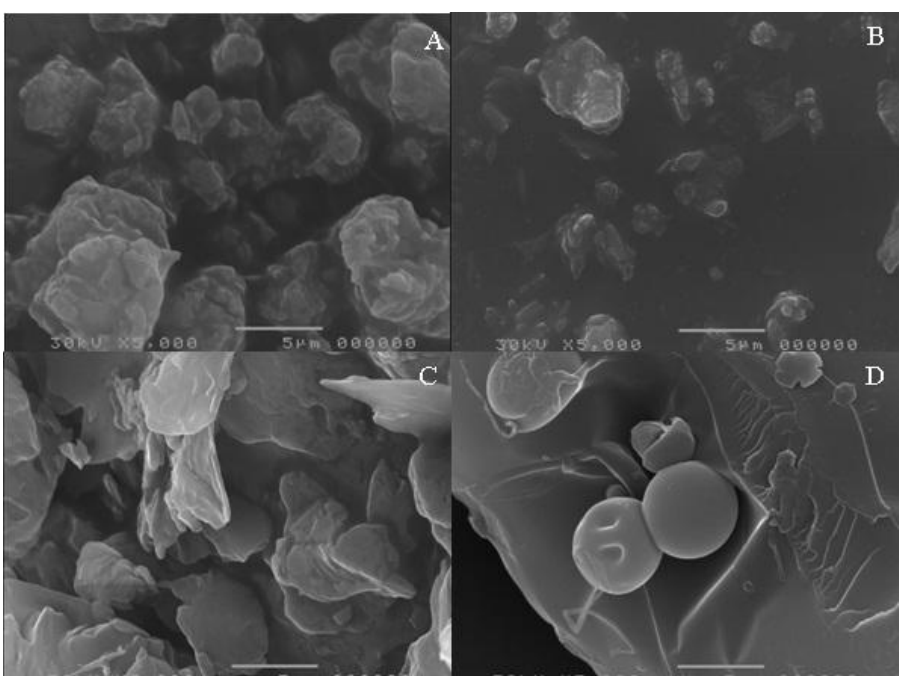
Figure 2. ( A ) Photomicrographs of unprocessed efavirenz (EFV); ( B ) micronized EFV; ( C ) unprocessed sodium lauryl sulfate (SLS); and ( D ) unprocessed polyvinylpyrrolidone